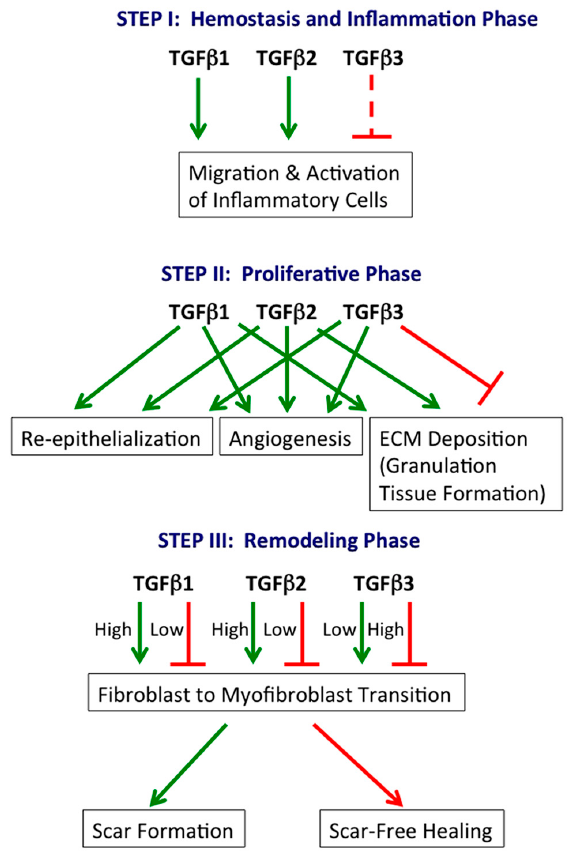
Figure 1. TGF β isoforms in cutaneous wound healing. TGF β 1, TGF β 2 and TGF β 3 play central roles in all three phases of wound healing. Generally, TGF β 1 and TGF β 2 are stimulatory, while TGF β 3 is inhibitory. However, TGF β 3 can also stimulate specific processes (e.g., re-epithelialization). Green arrow: stimulatory; continuous red line: inhibitory; dashed red line: potentially inhibitory, inferred from relative levels at the beginning (low) and end (high) of the hemostasis and inflammation phase.